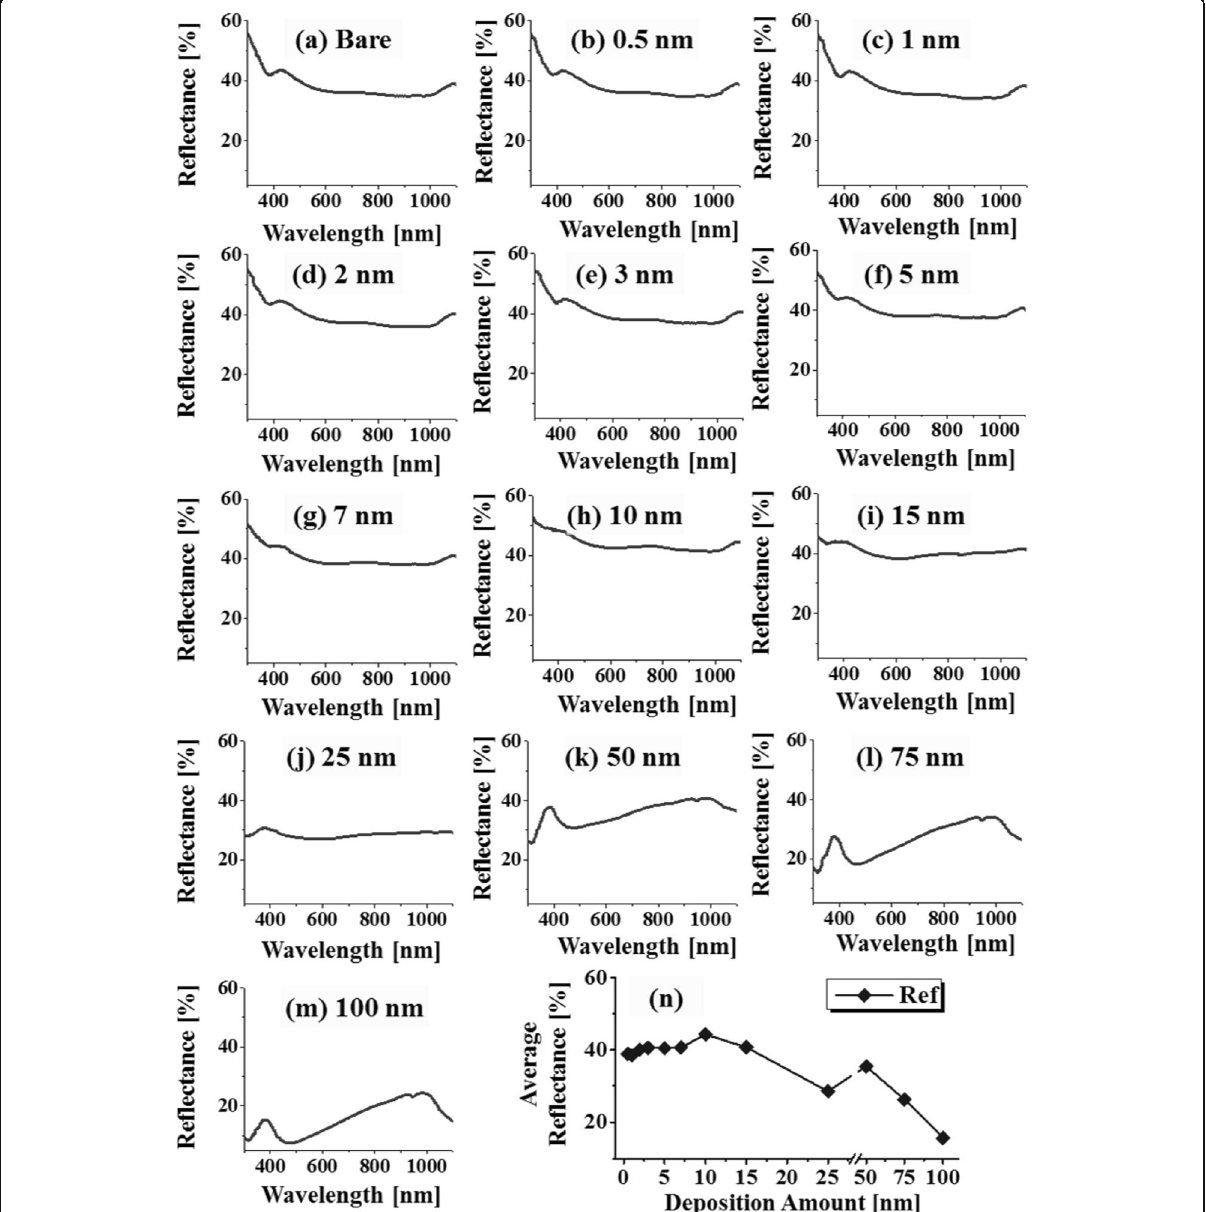
Fig. 4 Reflectance spectra of the Pd NPs on Si with various deposition amount from 0.5 to 100 nm, annealed at 575 °C for 450 s. a Bare silicon. b – m Samples with Pd nanostructures with the deposition amount as depicted. n Summary plot of average reflectance with respect to the deposition